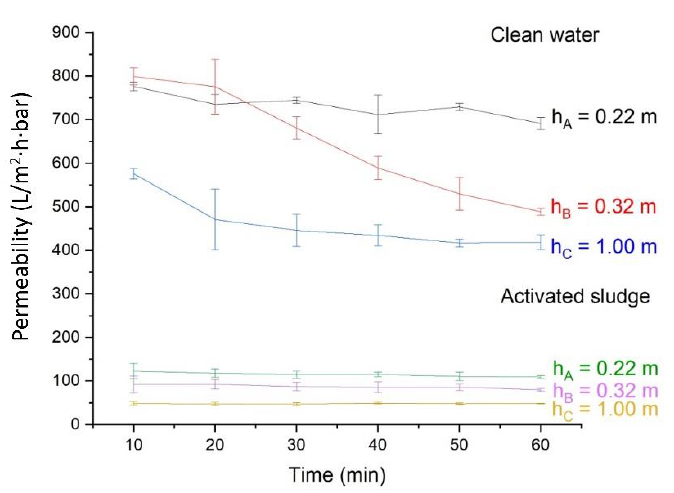
Figure 2. Clean water and activated sludge permeability function of hydrostatic pressure. The acti- vated sludge filtration test was evaluated using TS of 2782 mg/L.